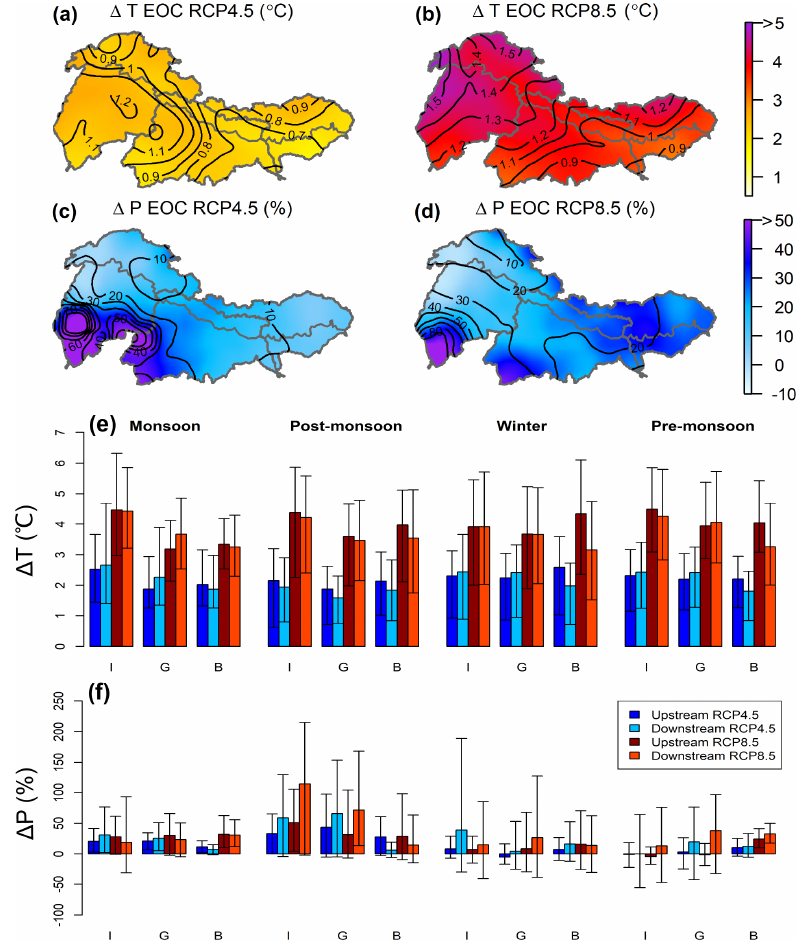
Figure 2. Maps showing the annual changes in temperature (a, b) and precipitation (c, d) between 2071–2100 and 1981–2010 for RCP4.5 and RCP8.5. The bar plots show seasonal changes in temperature (e) and precipitation (f) in the upstream and downstream domains of the IGB for RCP4.5 and RCP8.5. The contour lines within the maps and the error bars within the bar plots denote the ensemble range of the